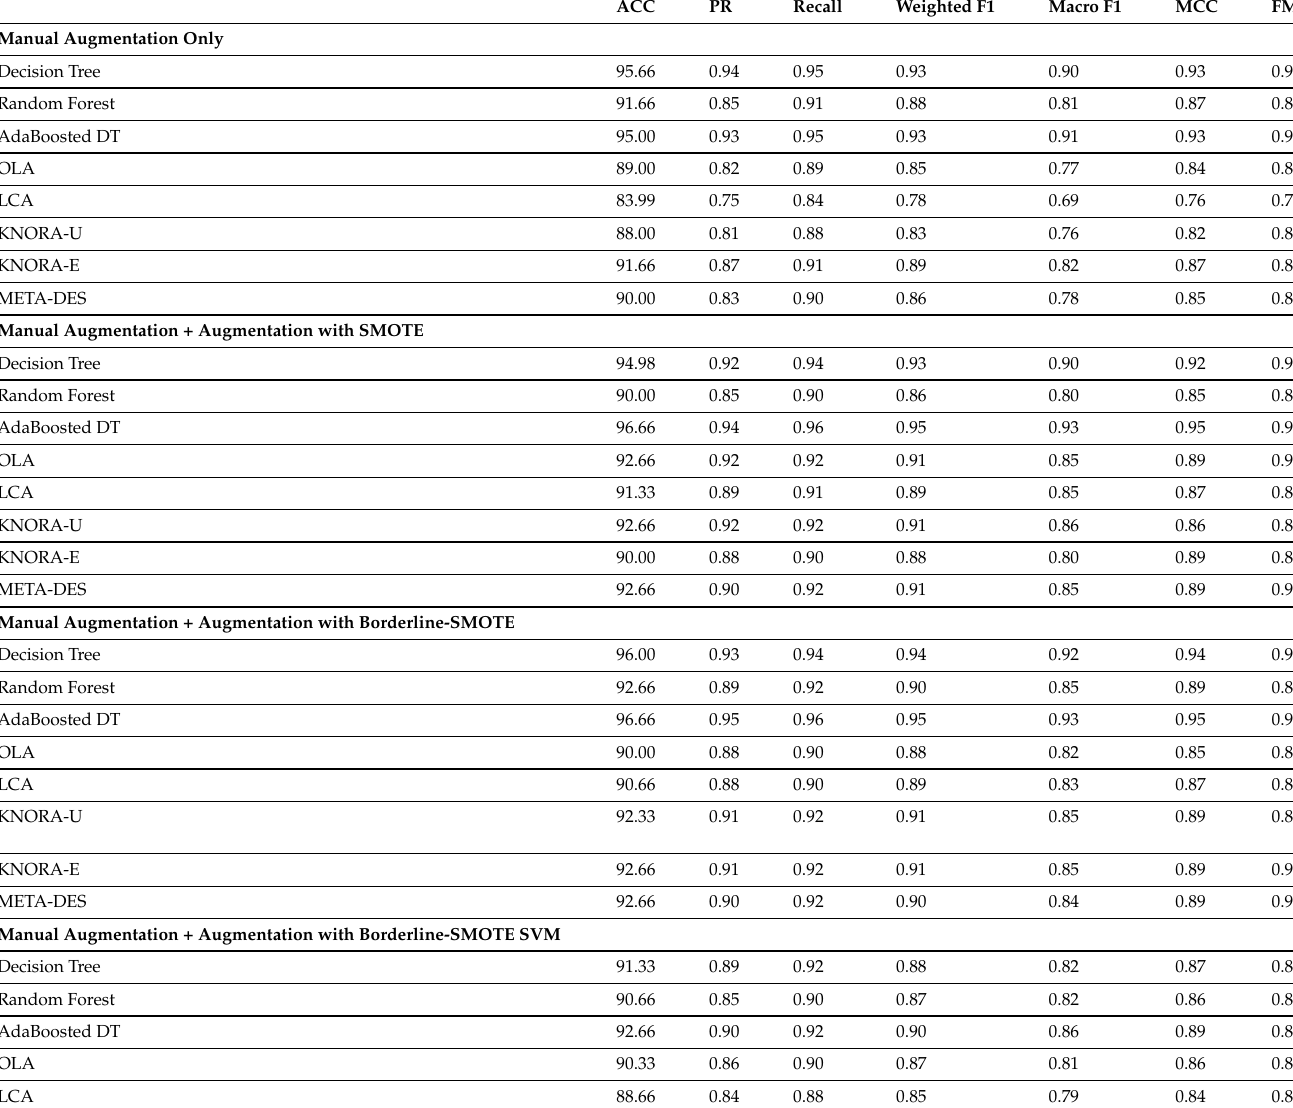
Table 6. Results for the nested CV method for the ensemble models implemented based on the framework proposed by Pineda-Bautista et al.